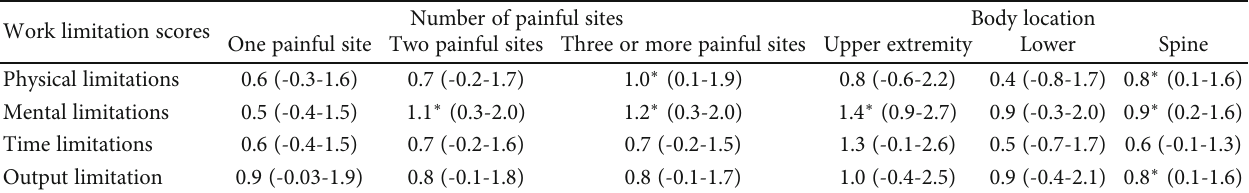
Table 5: E ff ect of area of body pain and number of painful sites on work limitation in FFs.